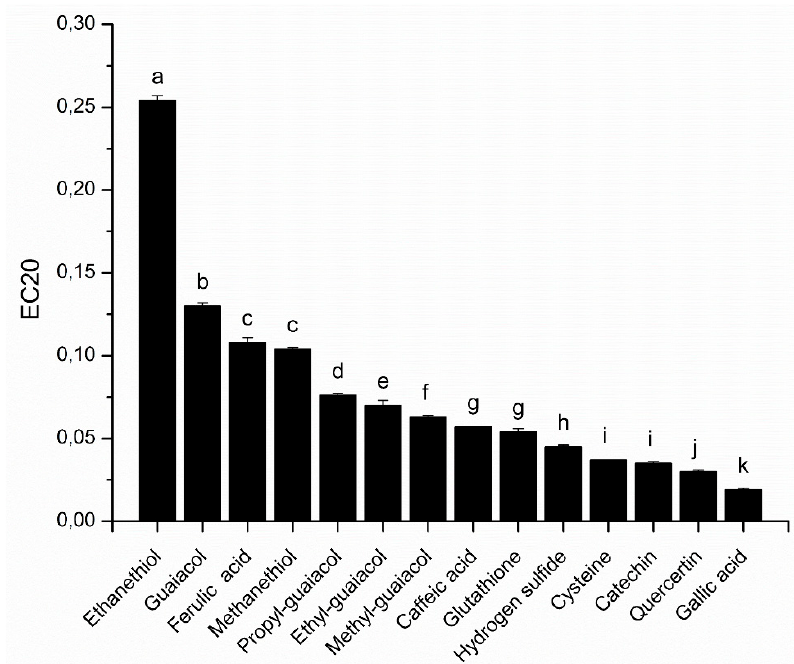
Figure 3. Comparison of the antioxidant capacity (EC20) of selected wine compounds using DPPH in methanol-buffer. Results of ANOVA and Tukey HSD tests: Different letters mark significant differences at p < 0.05.